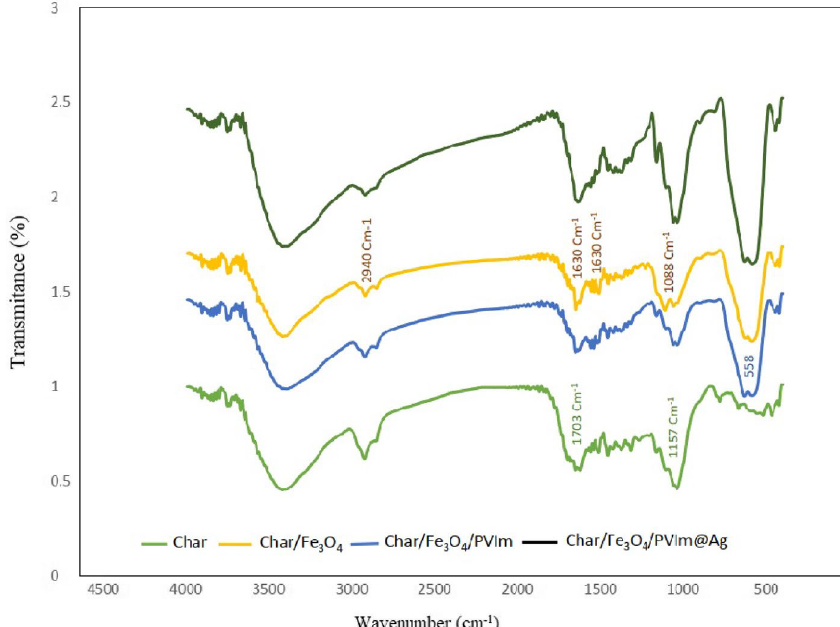
Figure 3. Fourier transform infrared (FT–IR) of biochar/Fe 3 O 4 /PVIm/Ag nanocatalyst.